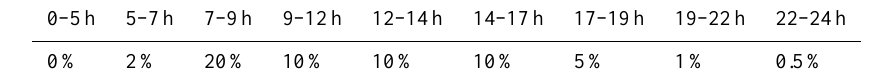
Table 3. Estimated percentage of the population outdoors through the day.